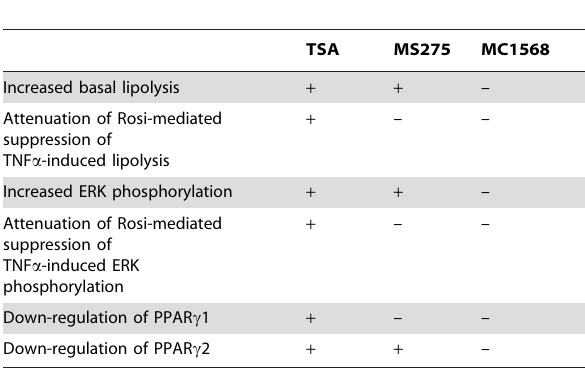
Table 1. Summary of the effects of HDACI treatment on lipolysis, ERK phosphorylation, and PPAR c levels.